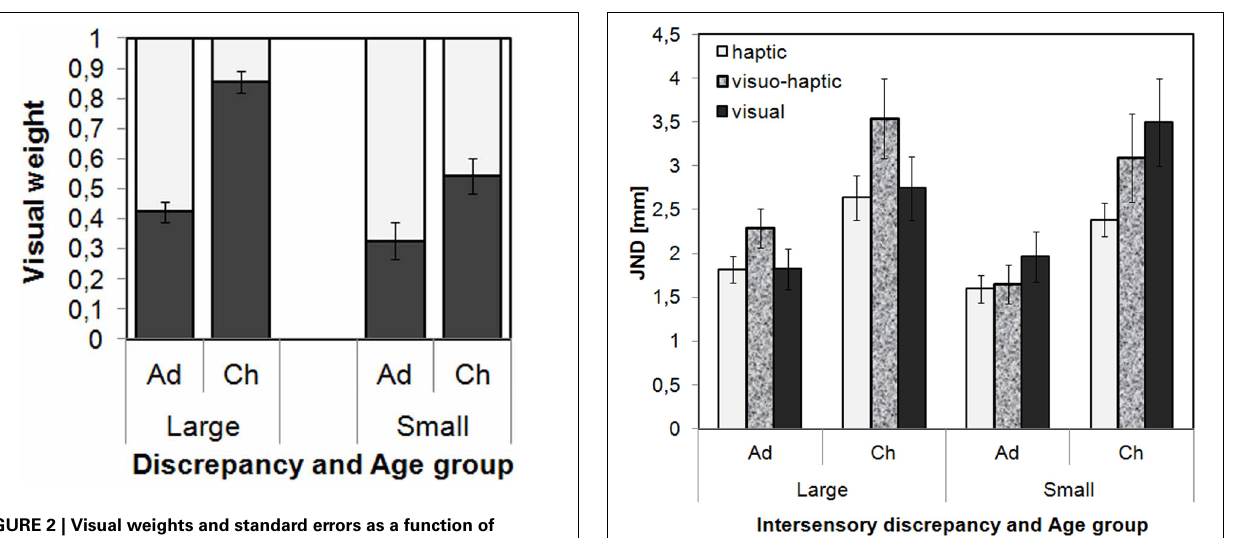
FIGURE 2 | Visual weights and standard errors as a function of Intersensory Discrepancy and Age Group (Ad[ults] vs. Ch[ildren]) averaged over the two conditions of Stimulus Set. The dark bars indicate the visual weights. Note that weights sum up to 1, so that the length of the light bars represents the haptic weights.